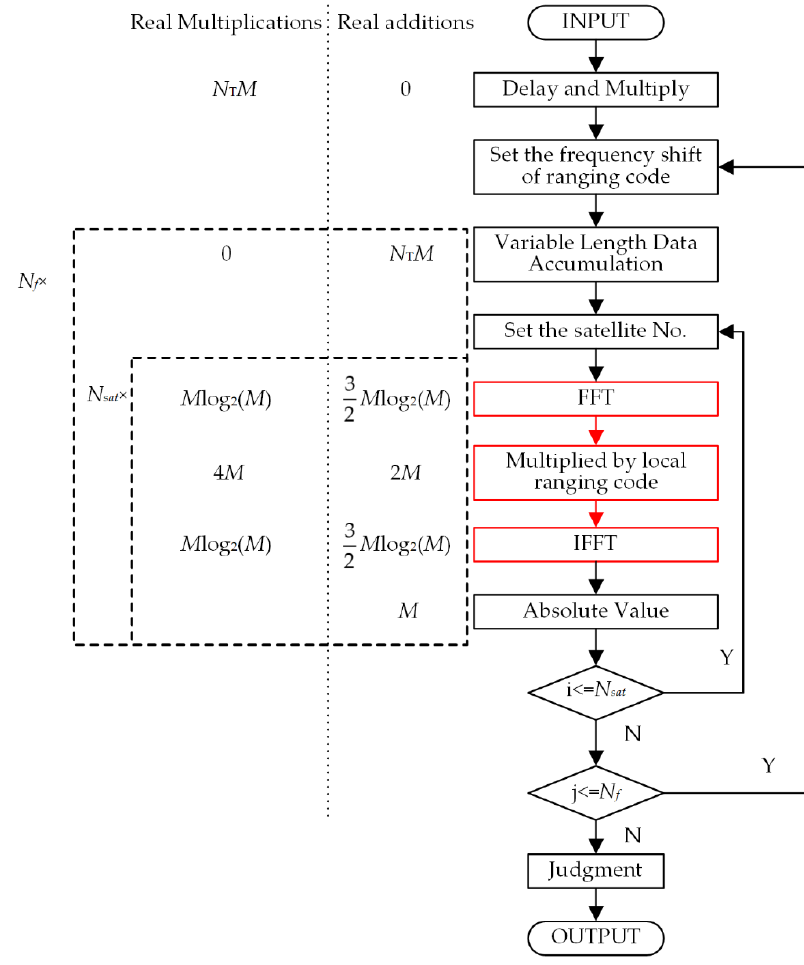
Figure 5. The flow diagram and the computational amount of the DAM ‐ VLDA acquisition scheme